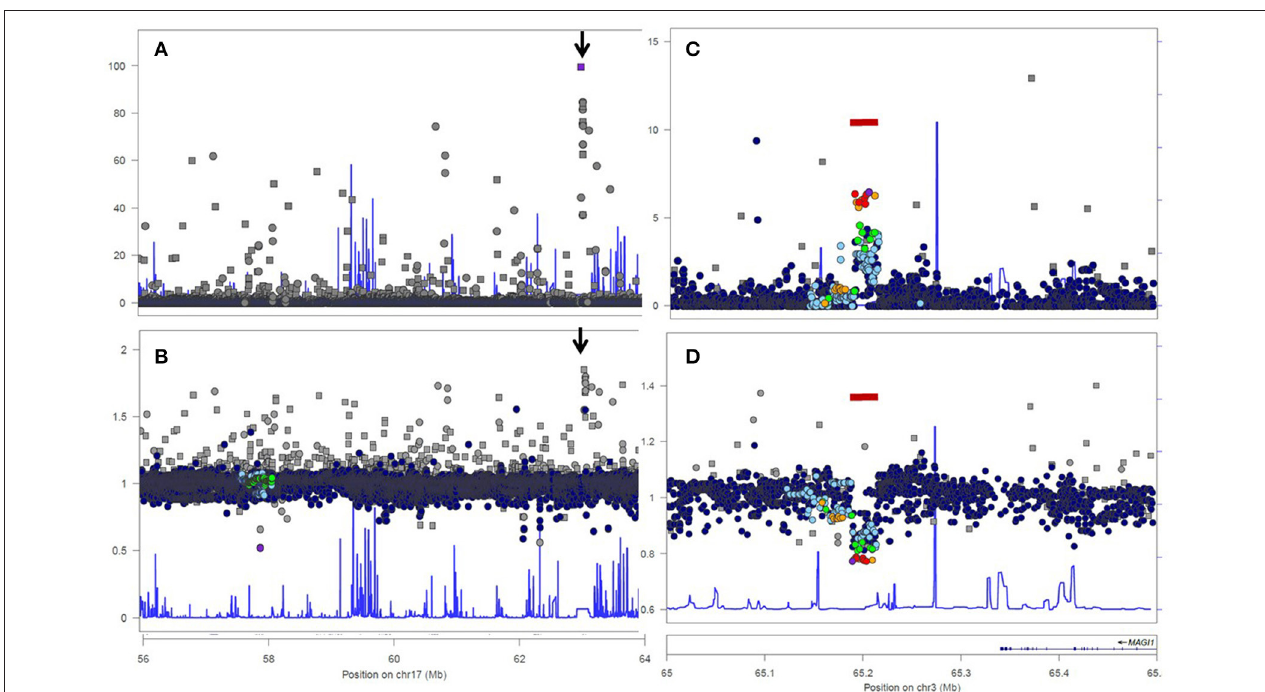
FIGURE 1 | Analysis of genotyped short variations in genomic region 17:56,000,000–64,000,000 (A,B) and genomic region 3:65,000,000–65,500,000 (C,D) from the 1000 Genomes Project, European Population. Upper figures (A,C) show log-transformed p -values for departures from HWE. Lower figures (B,D) show ratios of observed and expected (i.e., under Hardy-Weinberg Equilibrium) frequencies of heterozygous genotypes. Dots indicate true SNPs, rectangles symbolize variants of indel type. The bar (seen in C,D ) indicates common deletion variant esv2657253, (http://www.ensembl.org/Homo_sapiens/StructuralVariation/Explore?r=3: 65202694--65229573;sv,esv2657253;svf,3513219;vdb,variation). The arrow (seen in A,B ) points to a region with of a degenerate repeat structure within the 5’ end of the LRRC37A2 with strong homology with sequences of the LRRC37A3 gene, resulting in genotyping